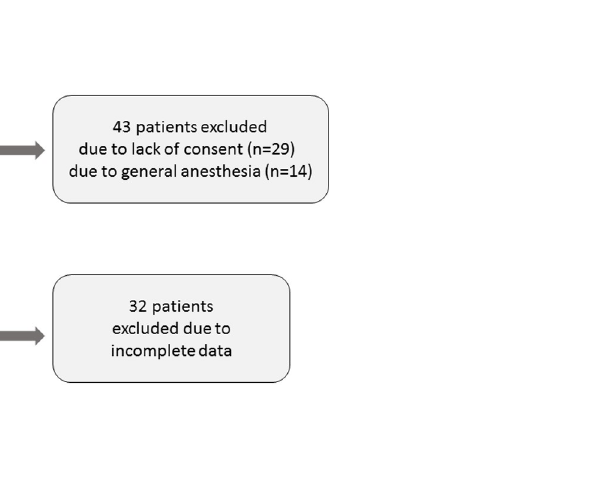
Fig 1. Participants flow